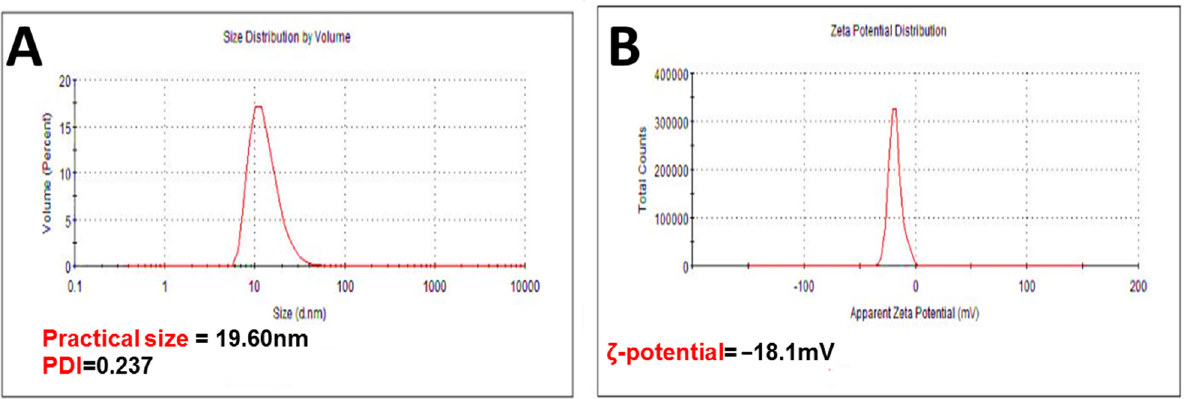
Figure 5. ( A ) Hydrodynamic size and polydispersity index (PDI) of SRLe - α Fe 2 O 3 NPs; ( B ) ζ -potential of SRLe - α Fe 2 O 3 NPs. Numerical data are reported as the mean ± SD ζ -potential ( n = 3) and particle size and PDI ( n = 4).